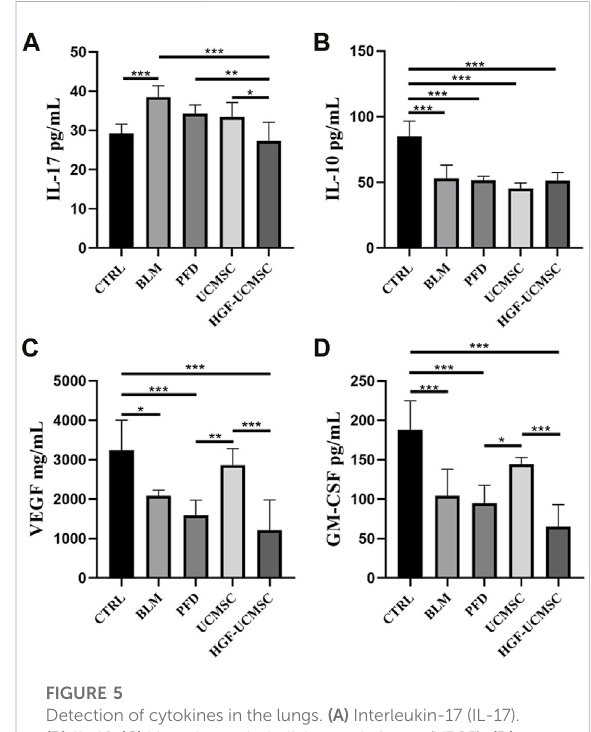
FIGURE 5 Detection of cytokines in the lungs. (A) Interleukin-17 (IL-17). (B) IL-10 (C) Vascular endothelial growth factor (VEGF). (D) Granulocyte-macrophage colony-stimulating factor (GM-CSF).